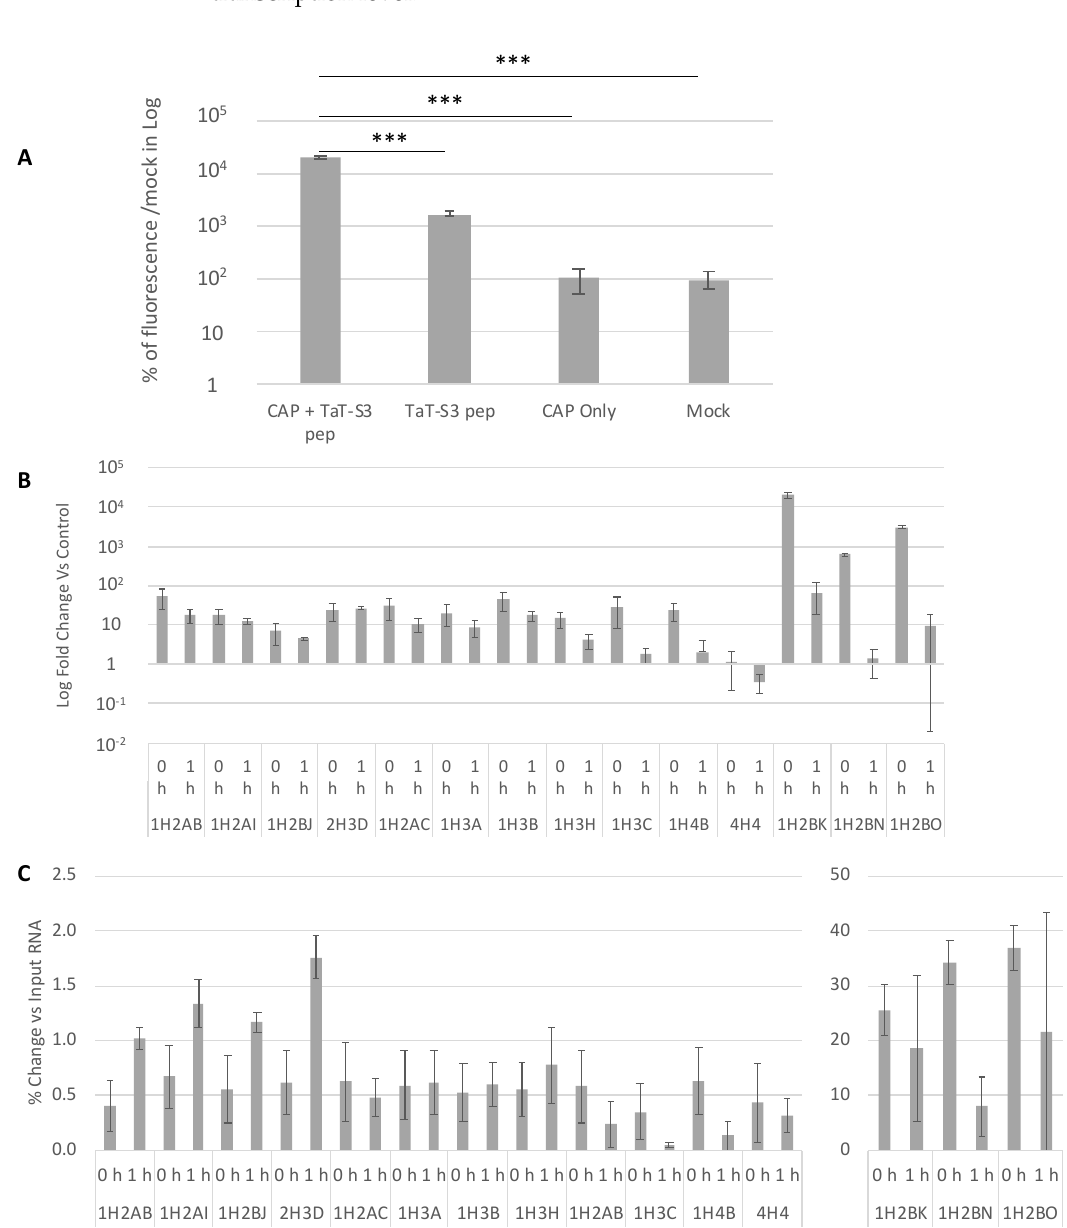
Figure 6. ( A ) The fluorescence intensity of RNA oxidation probed in situ with fluorescence-tagged 8-oxoG binding peptide probe on CHCP-treated or untreated live MDA-MB-231 cells. The average SEM of the ratios is plotted. ANOVAs were used followed by post-hoc comparisons using Student’s t- test with Bonferroni corrections as appropriate. *** p < 0.001. ( B ) Pull-down of 8-oxoG histone RNA; the fold-change of immunoprecipitated 8-oxoG histone RNA after 0 and 1 h post-CAP treatment compared to immunoprecipitated 8-oxoG mock control samples of MDA-MB-231 cells. ( C ) The percentage change of 8-oxoG modification in histone genes at zero-hour and one-hour incubation after CAP treatment in MDA-MB-231 cells between the CAP-8-oxoG immunoprecipitated group and input group.